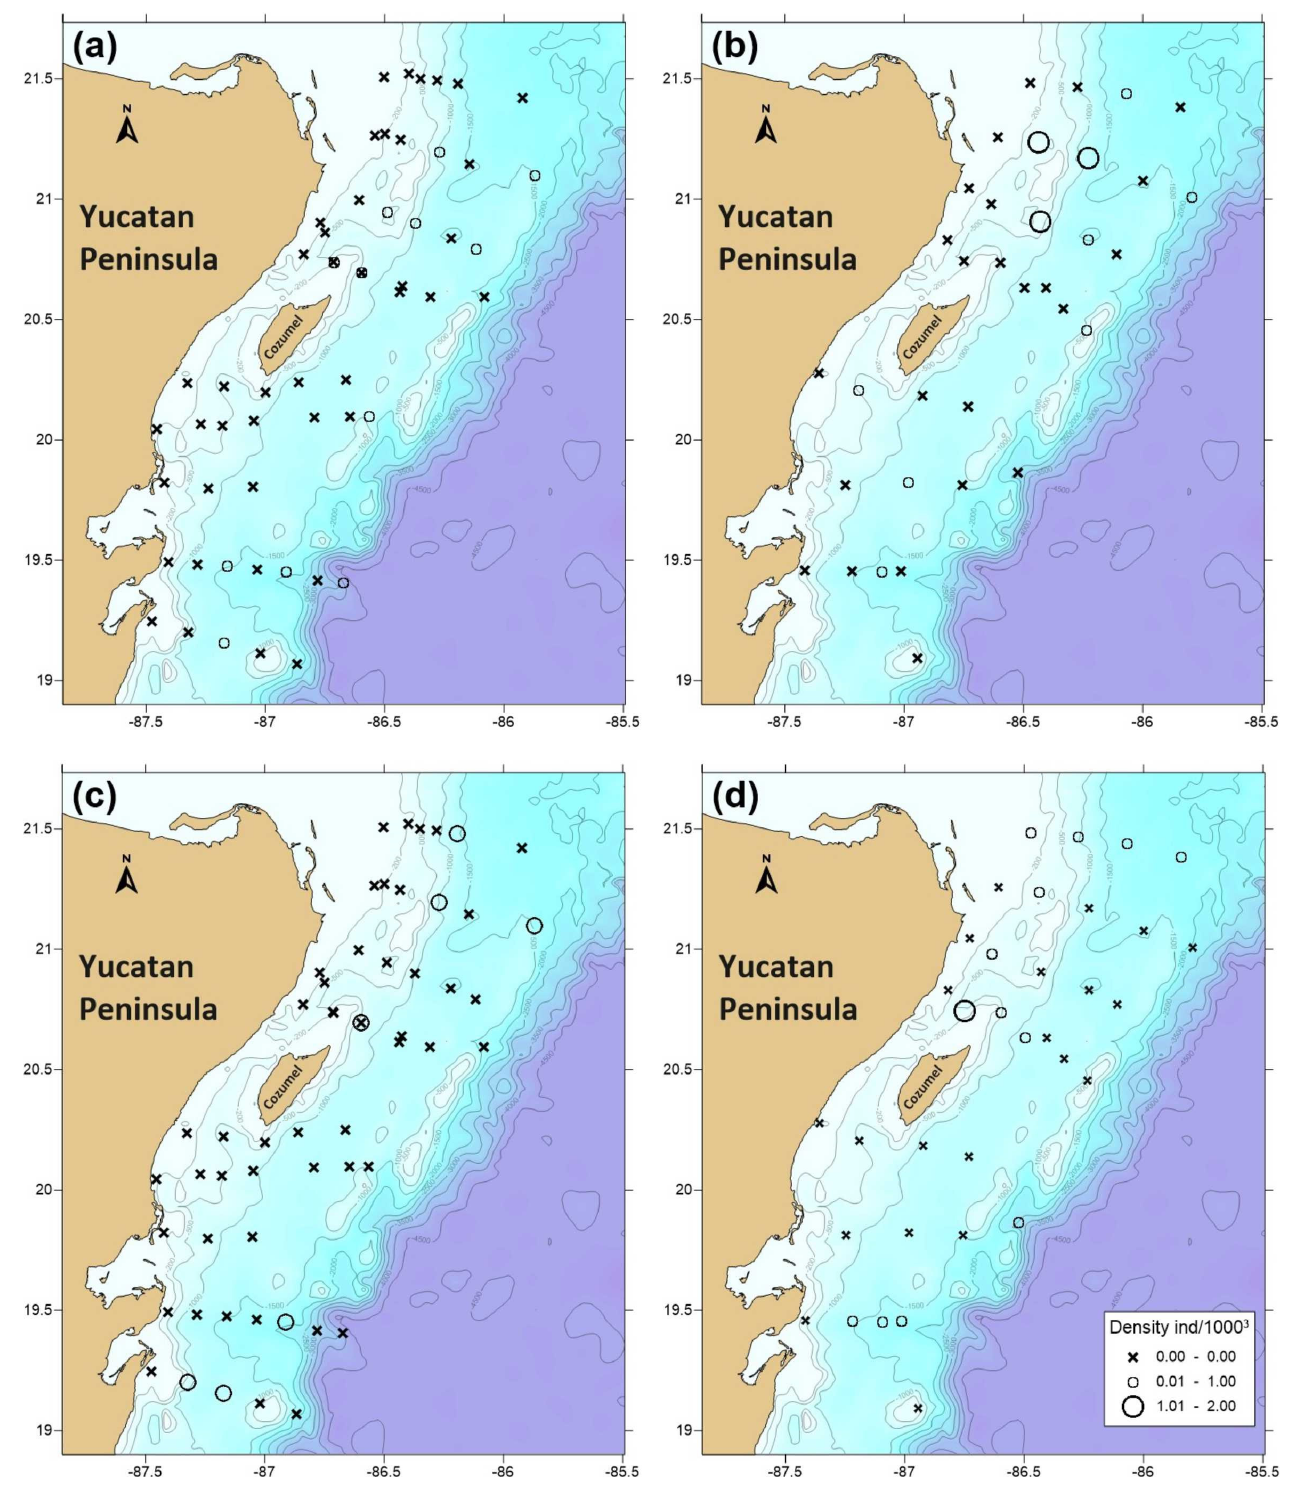
Figure 8. Density (number of larvae per 1000 m 3 of water) of phyllosomata by sampling station. Scyllarides aequinoctialis : ( a ) mid-stage phyllosomata, autumn cruise; ( b ) mid-stage phyllosomata, spring cruise; ( c ) late-stage phyllosomata, autumn cruise. Scyllarus chacei : ( d ) late-stage phyllosomata, spring cruise. The scale is the same for all panels.